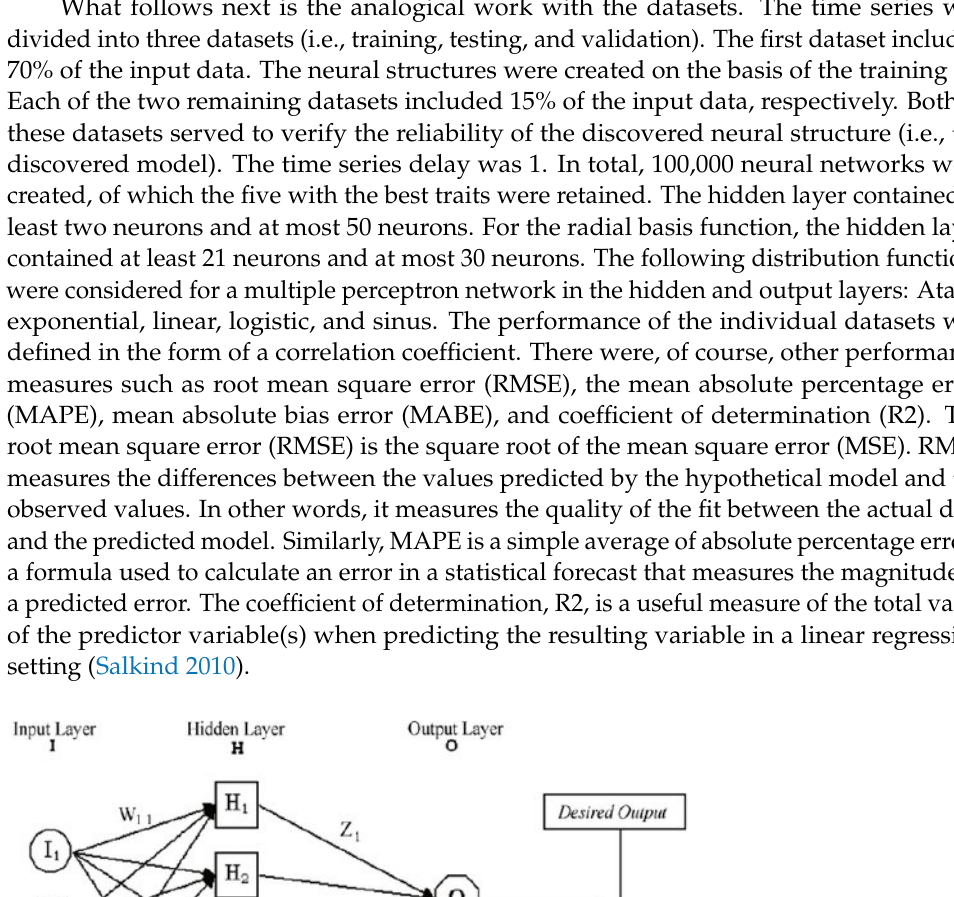
Table 1. Characteristics of the dataset.